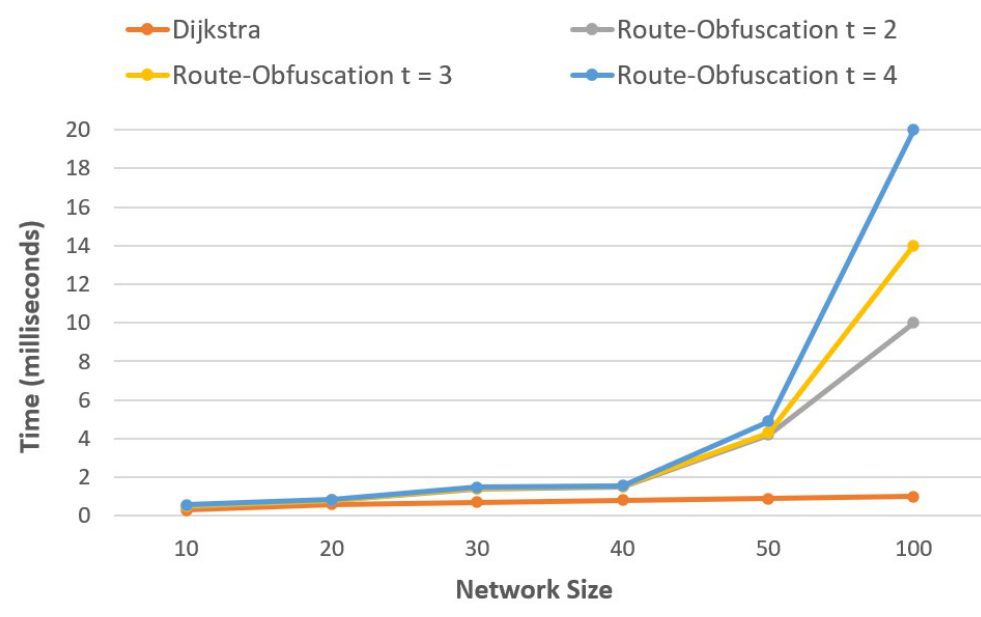
Figure 6. Time complexity with different network